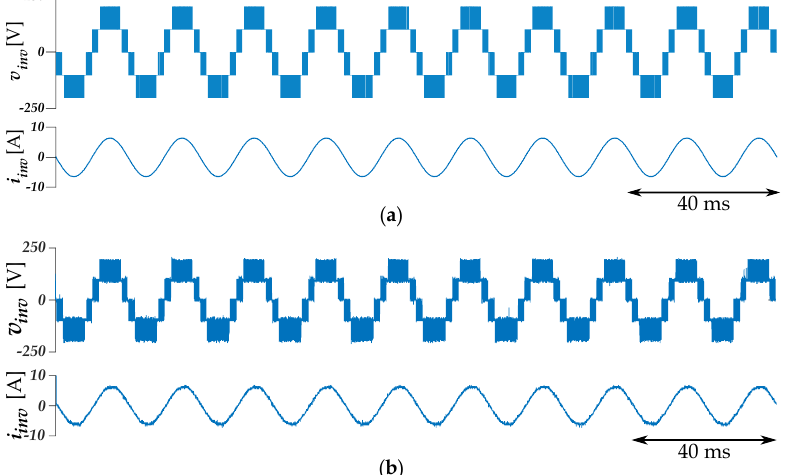
Figure 13. Stand alone steady state output voltage and current waveforms with resistive load. ( a ) Simulated waveforms. ( b ) Experimental